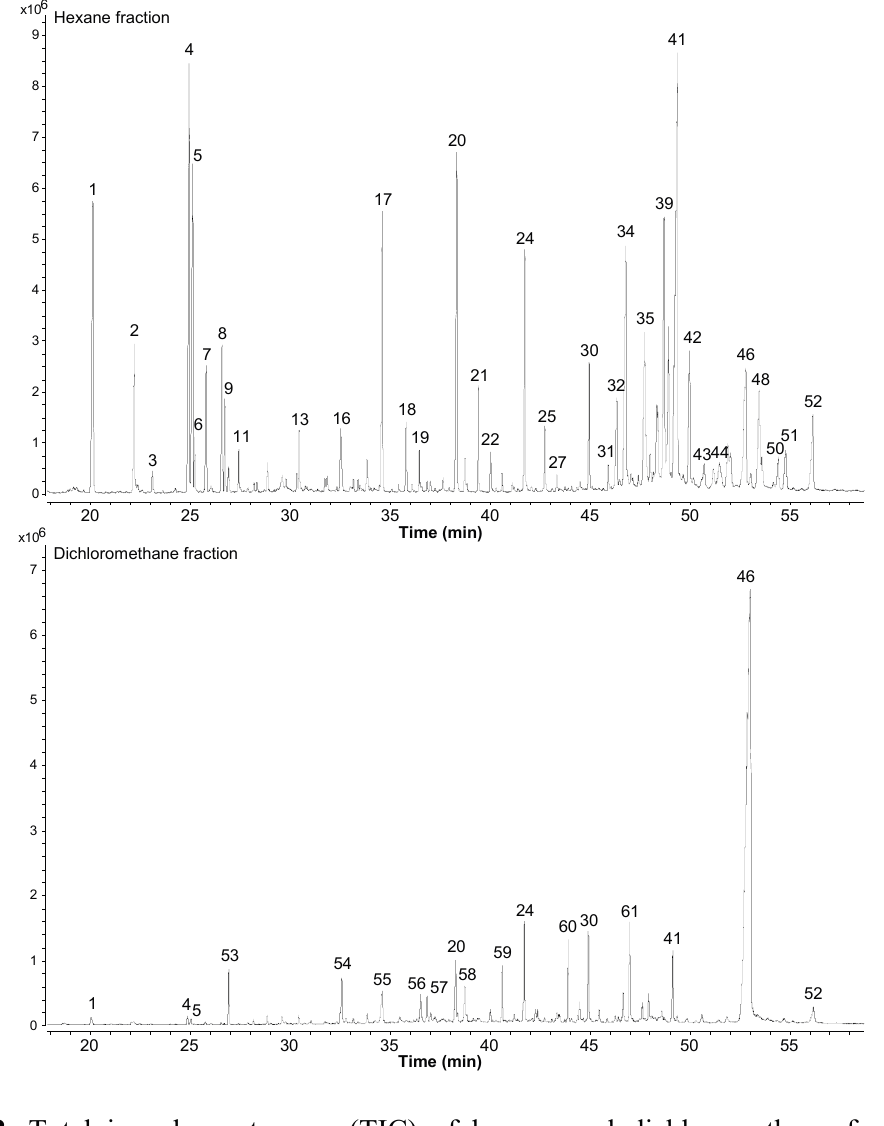
Figure 2. Total ion chromatogram (TIC) of hexane and dichloromethane fractions of Mimosa caesalpiniifolia in GC-qMS